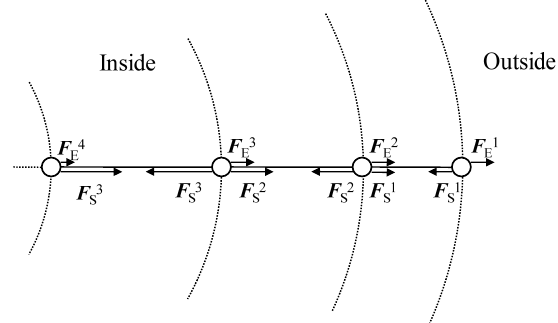
Figure 12. Schematic illustration of the force balance on the nanogel network. Circles and solid lines express crosslinks and individual polymers,